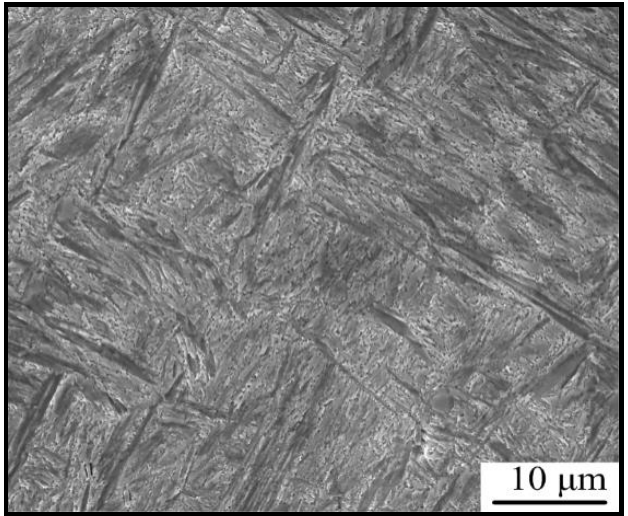
Figure 3. Microstructure after six passes deformation after quenched in water. This indicates that the reversal transformation from ferrite to austenite occurred during the six passes plane strain compression. It testified the hypothesis of the occurrence of the reversal transformation from ferrite to austenite during the multi-pass high strain rate compression. The reversal transformation austenite formation during the compression is characterized as shown in Figure